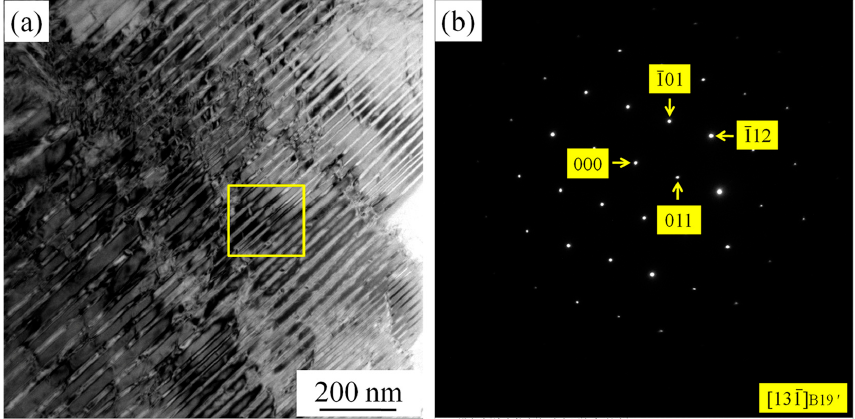
Figure 5. TEM micrographs of NiTiCu SMA subjected to compression deformation at 700 °C: ( a ) Bright field image showing the existence of dislocation substructures in martensite laths; ( b ) Diffraction pattern of (a). Metals 2017 , 7 , 294